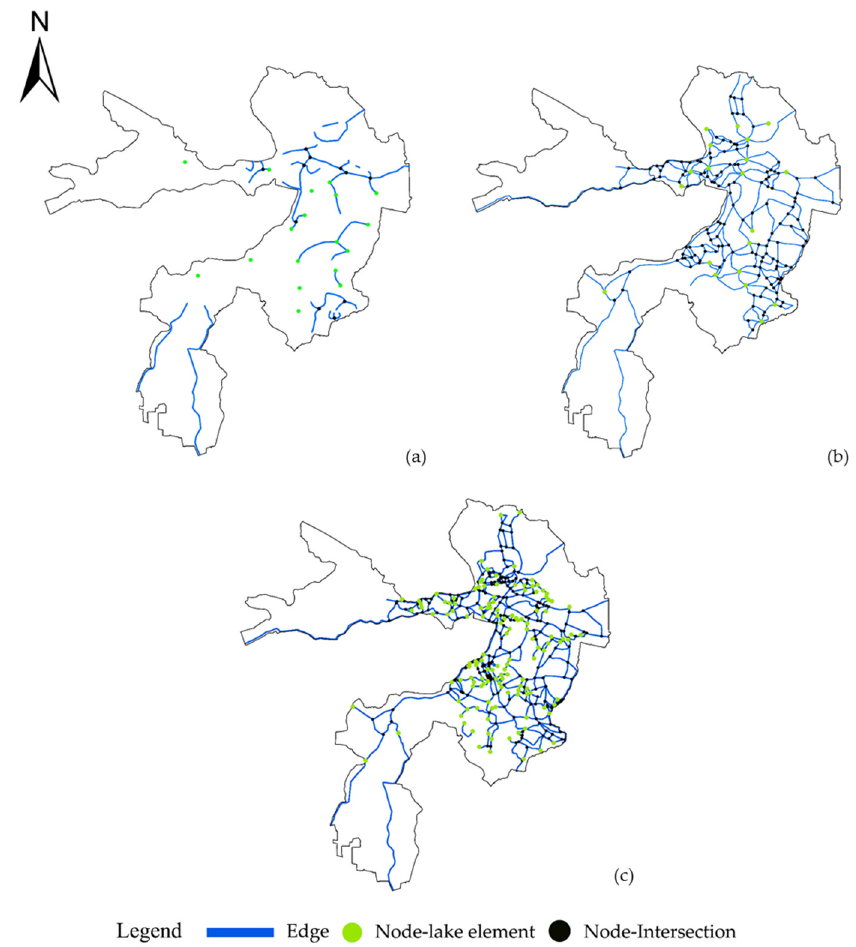
Table 10. Statistics for the river system network elements with different grades.